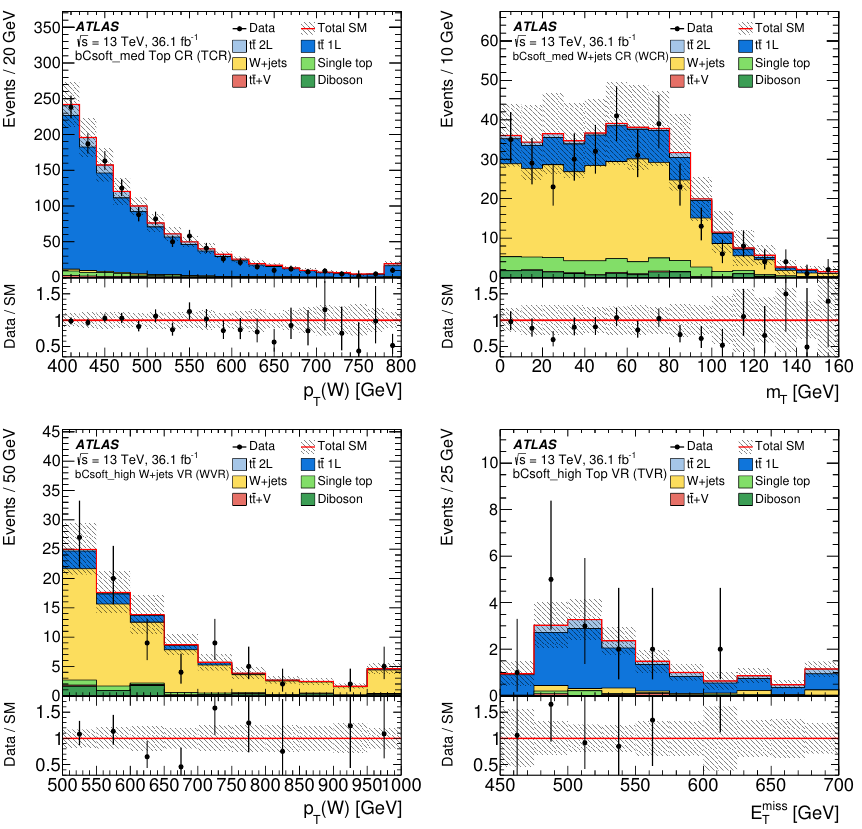
Figure 13 . Kinematic distributions in the control regions associated with bCsoft med and the validation regions associated with bCsoft high : (top left) p W m T in the W +jets control region, (bottom left) p T of the leptonically decaying W boson ( p W the W +jets validation region, and (bottom right) E miss backgrounds is scaled by a normalisation factor obtained from the corresponding control region. The hatched area around the total SM prediction and the hatched band in the Data/SM ratio include statistical and experimental uncertainties. The last bin contains